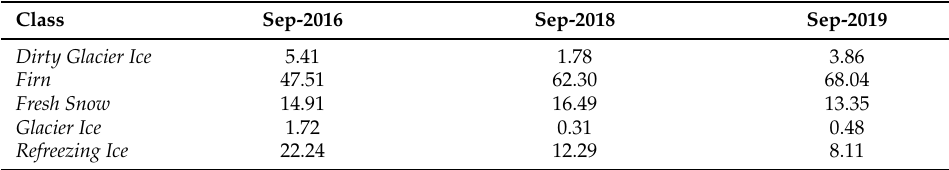
Table 7. Area statistics in % for the months of September in